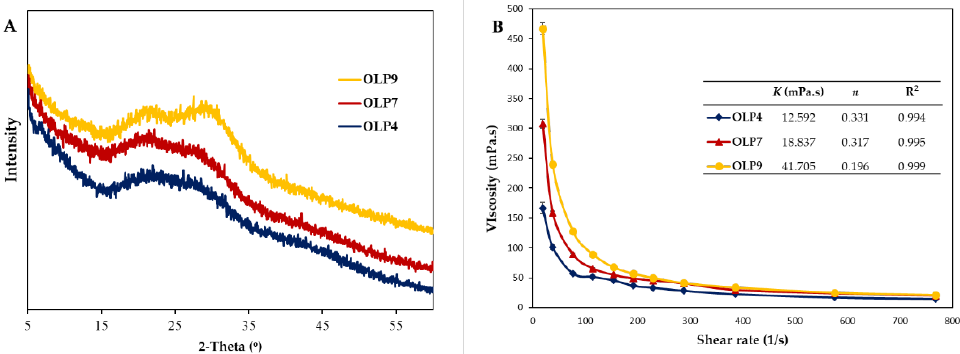
Figure 2. X-ray diffractogram ( A ) and apparent viscosity at different shear rates ( B ) of polysaccharides from okra leaves (OLPs). In Figure 2B (inset), K and n denote the power-law model’s flow consistency and flow behavior index (Equation (1)).